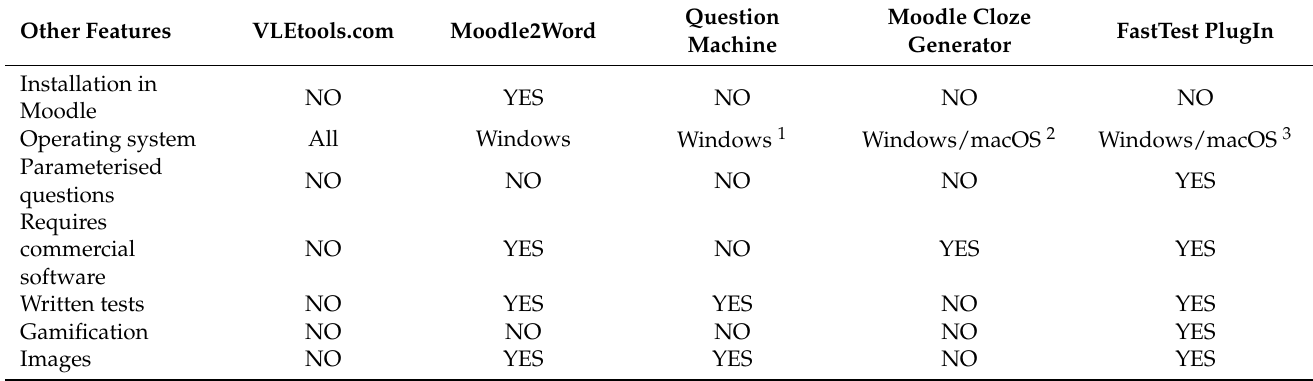
Table 7. Comparison of other